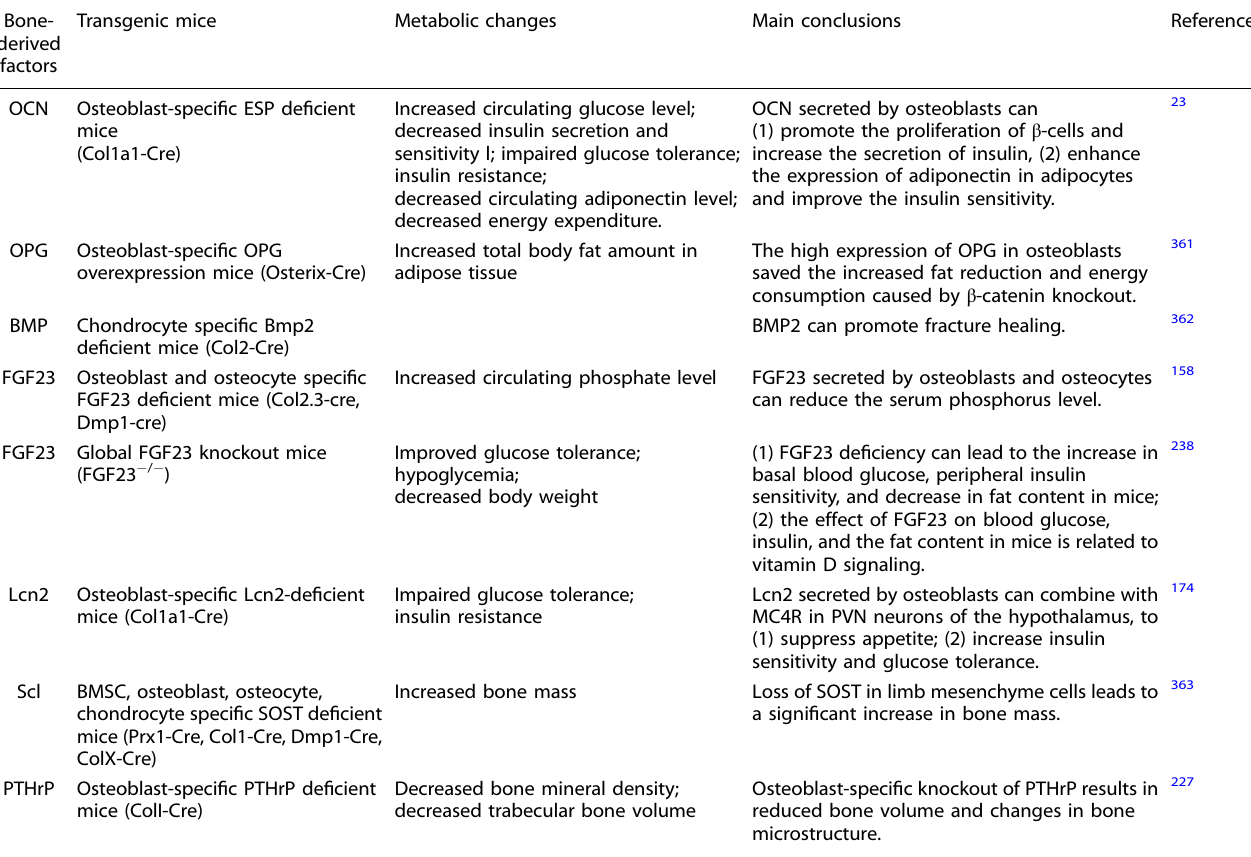
Table 2. Conditional gene knockout mice used for studies of energy metabolism and bone